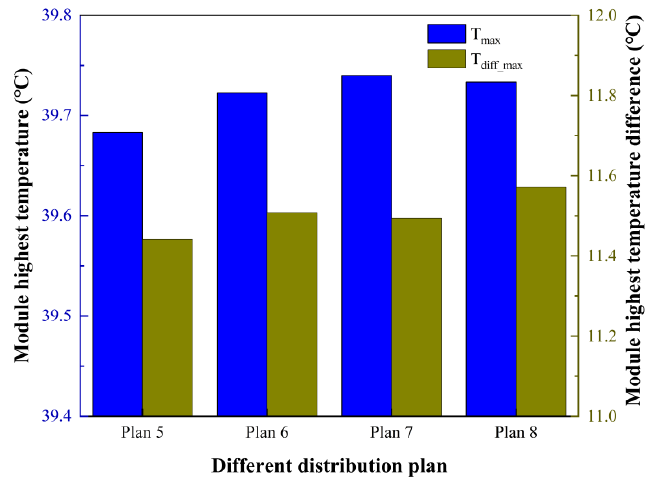
Figure 12. Module temperature under different distribution plans.